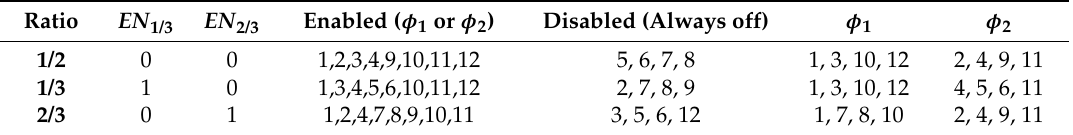
Figure 8. Multi-ratio, multi-leaf SC converter stage structure ( a ) Simplified diagram. ( b ) Operation Table 2. Switching